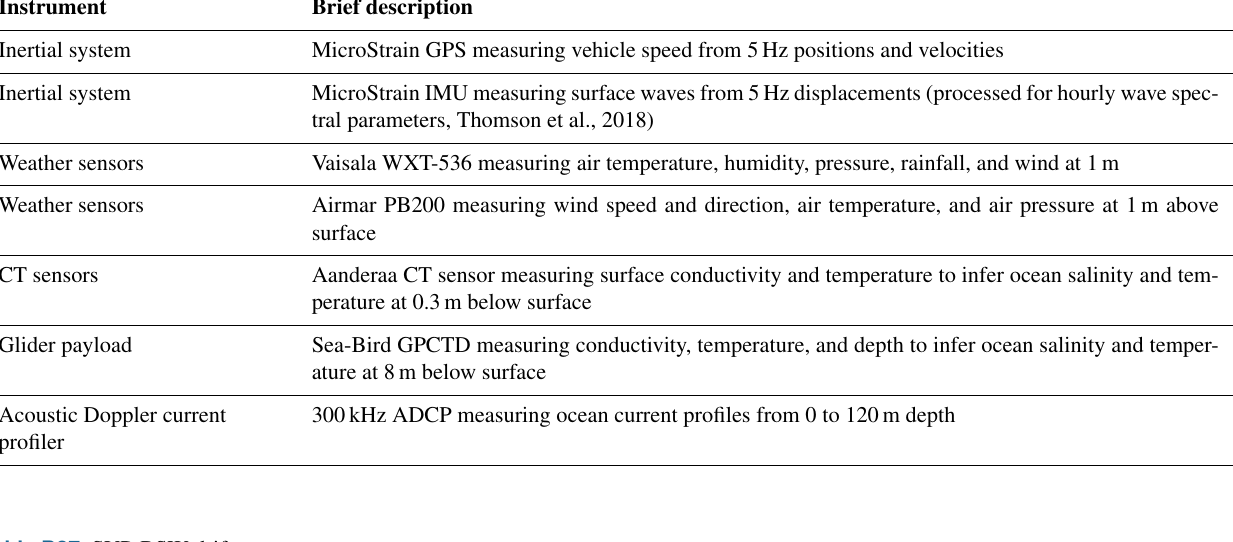
Table B26. Wave Gliders.